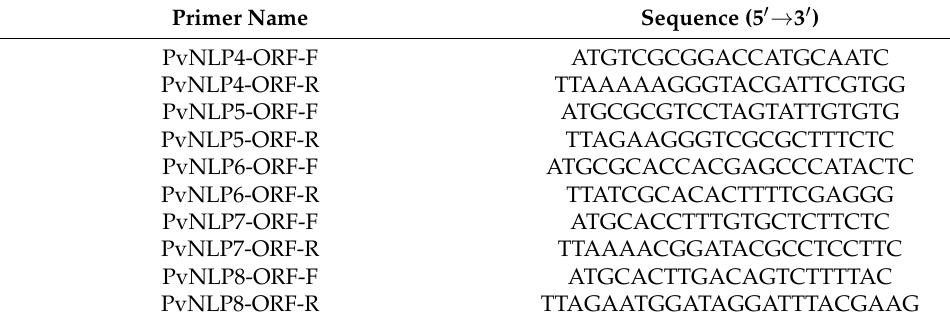
Table 1. Oligonucleotides used for sequencing PvNLP